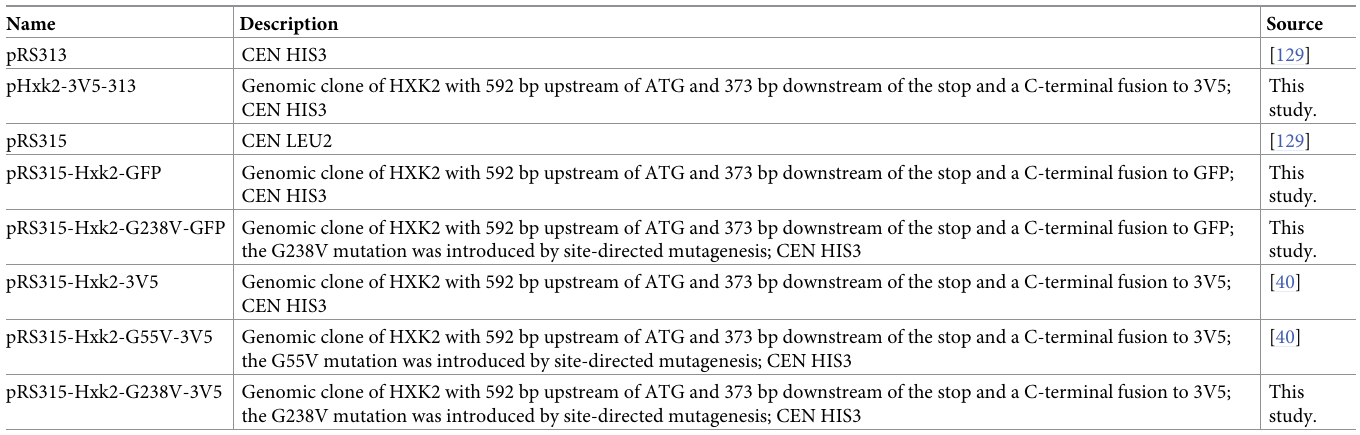
Table 4. Plasmid DNA used in the current